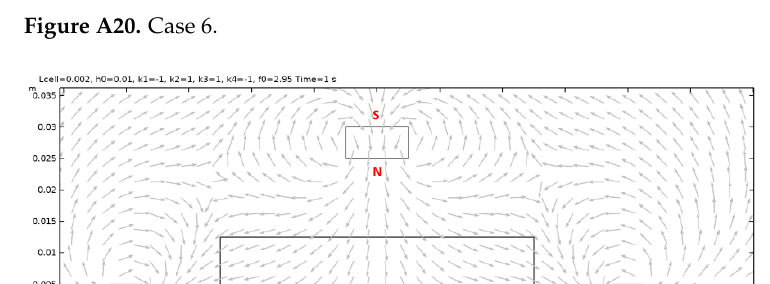
Figure A20. Case 6. Figure A20. Case 6.